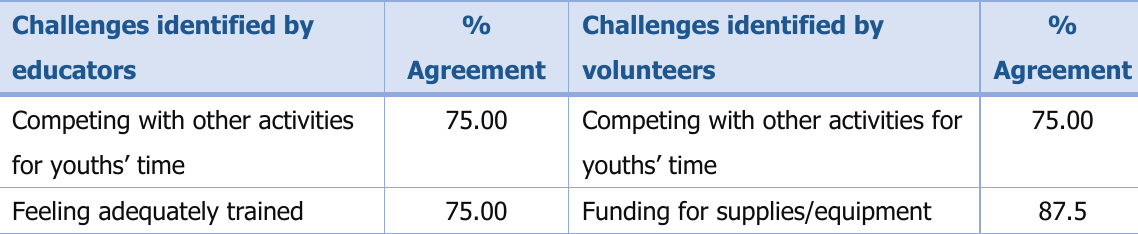
Table 5. Comparison of Perceived Challenges Identified by 4-H Educator and 4-H Volunteer